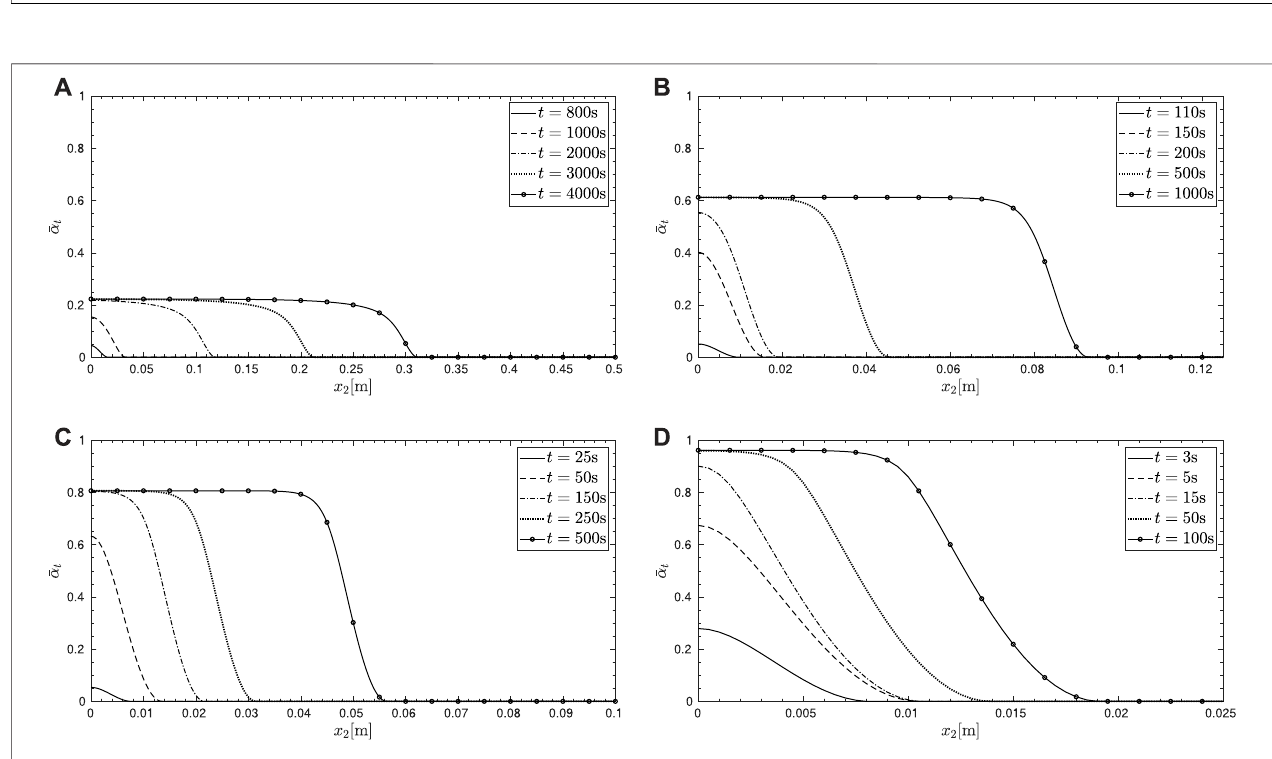
FIGURE 6 | Evolution of damage for values of w 1 (A) 2000 N.m − 3 , (B) 1000 N.m − 3 , (C) 500 N.m − 3 , and (D) 100 N.m − 3 .